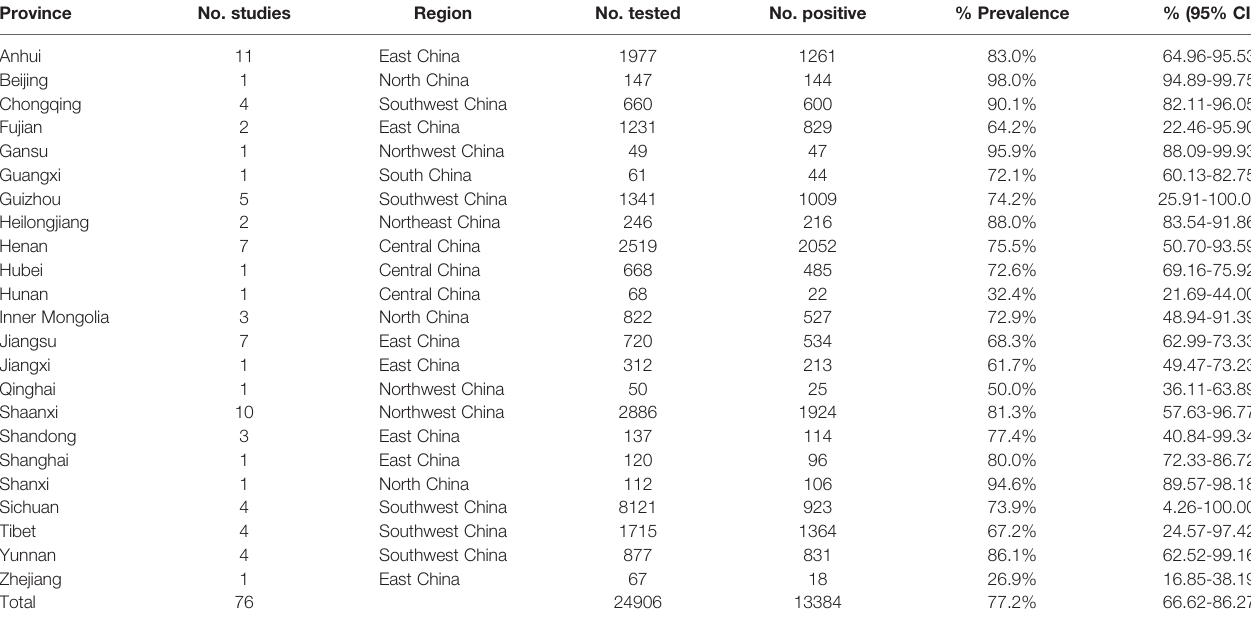
TABLE 3 | Pooled prevalence of Eimeria spp. by provincial in China. Province No.